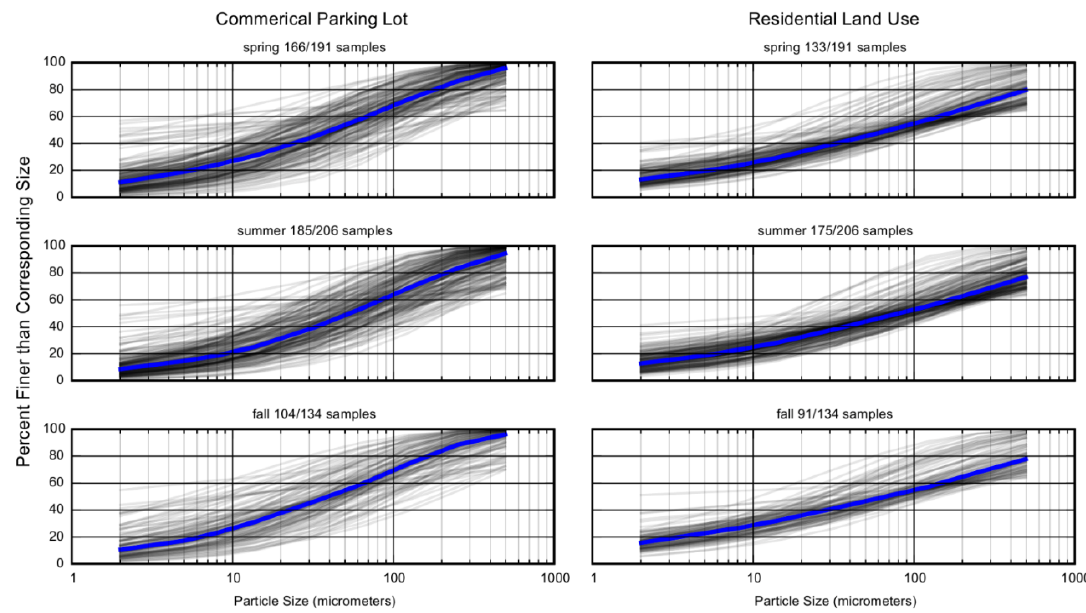
Figure 3. Predicted seasonal particle size distribution curves in the commercial parking lot and residential basin study areas using regression equations described in Selbig and Fienen [19] over 13 years of measured climate data. The text above each panel details the number of simulated distributions retained after regression analysis over the total number of storm events evaluated by season. The blue line represents the median value.